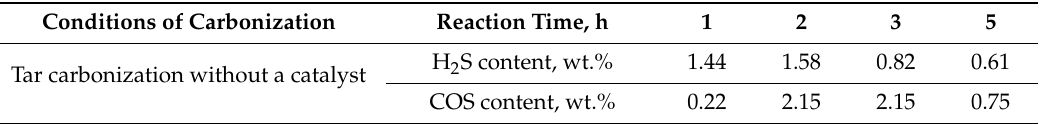
Table 6. Concentrations of sulfur-containing compounds in gaseous products of tar carbonization at 450 ◦ C as a function of reaction time.